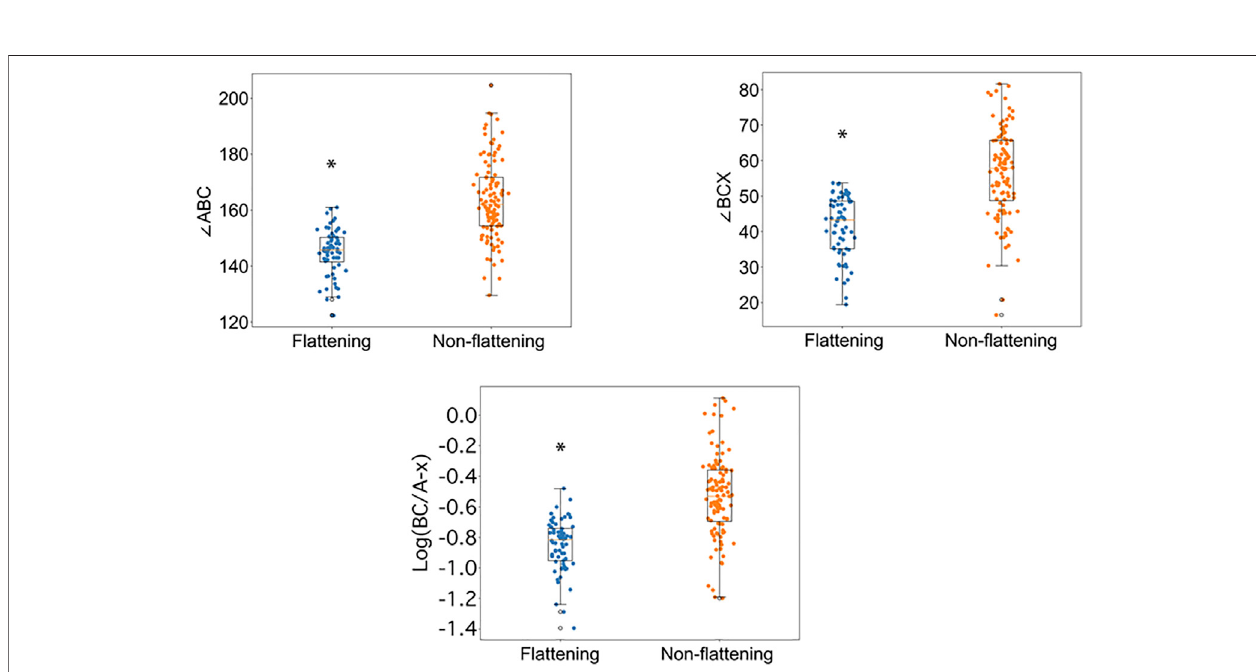
FIGURE 4 | Differences in ∠ ABC, ∠ BCX, and log (BC/A-x) between the fl attening and the non- fl attening groups. The fl attening and the non- fl attening groups were identi fi ed by an expert pulmonologist. *: p < 0.0001.